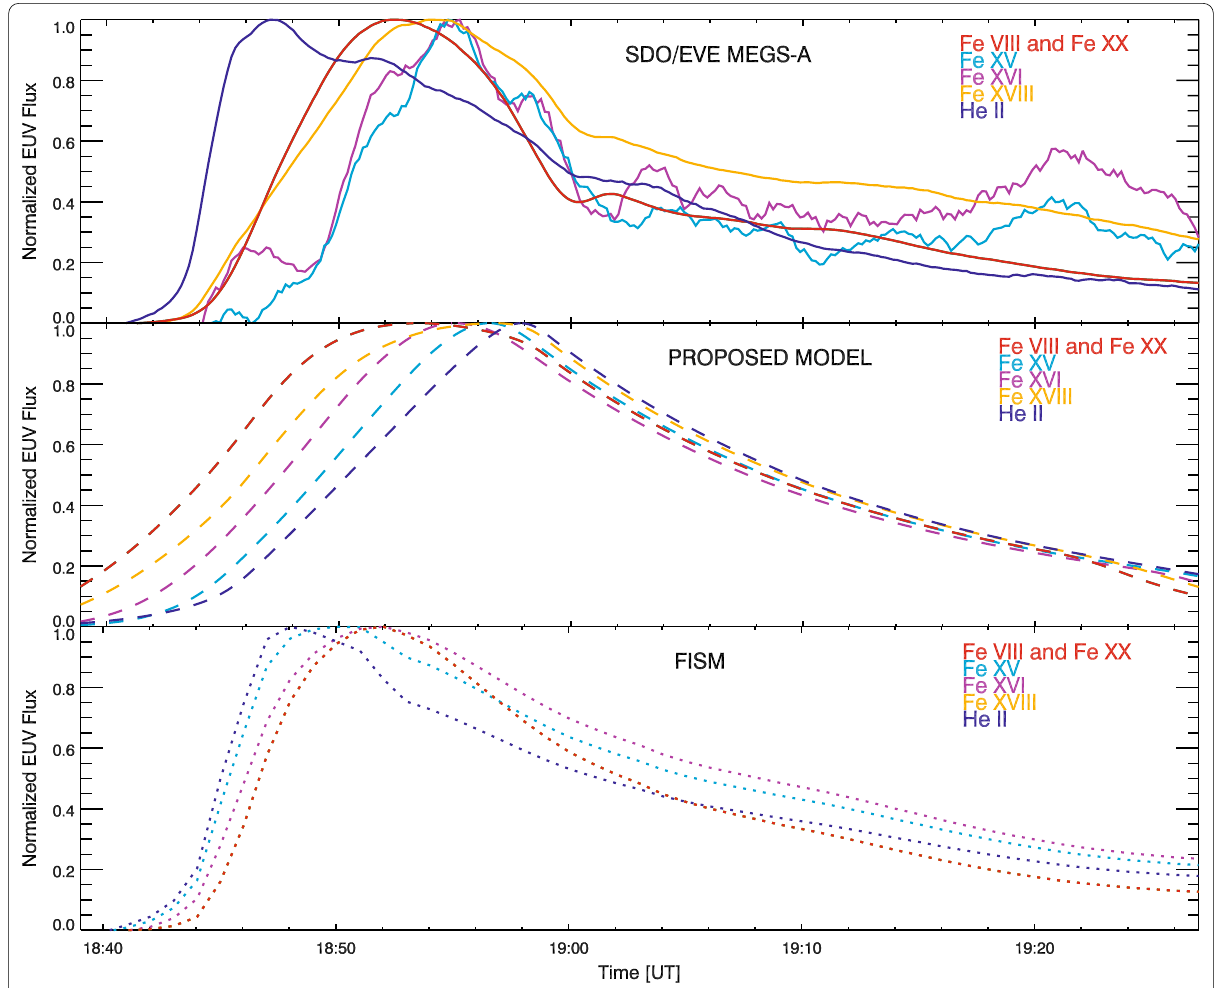
Fig. 9 Example of EUV flare line light curves. The EUV flare line light curves for the M9.9-class flare on January 1, 2014. The wavelength resolution of the light curves was 10 Å, which is the same as that of FISM. The panels indicate the light curves of Fe VIII and Fe XX 130 Å (red), Fe XV 280 Å (cyan), Fe XVI 330 Å (purple), Fe XVIII 90 Å (orange), and He II 300 Å (blue) obtained by the SDO/EVE MEGS-A observation (top panel: solid line), the proposed model estimation (middle panel: dashed line), and FISM estimations (bottom panel: dotted line), respectively. The slope of the regression and correlation coefficient (CC) for each model are shown at the upper left and bottom right